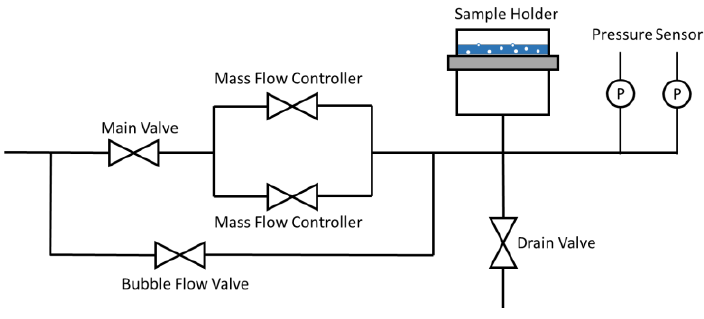
Figure 7. Schematic structure of the porometer test rig.